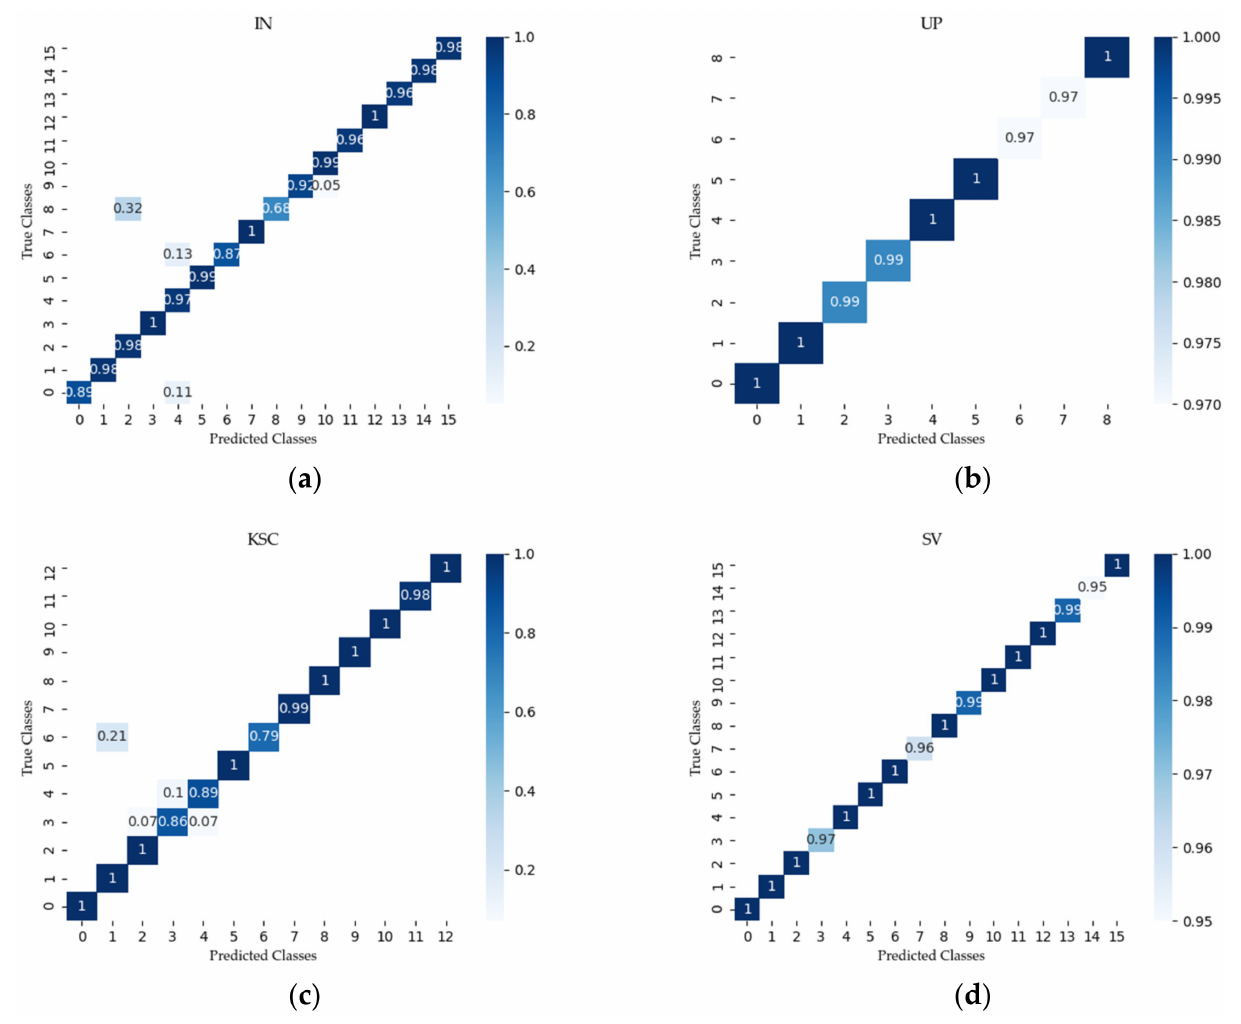
Figure 13. Confusion matrix using the proposed method for ( a ) IN, ( b ) UP, ( c ) KSC, and ( d )